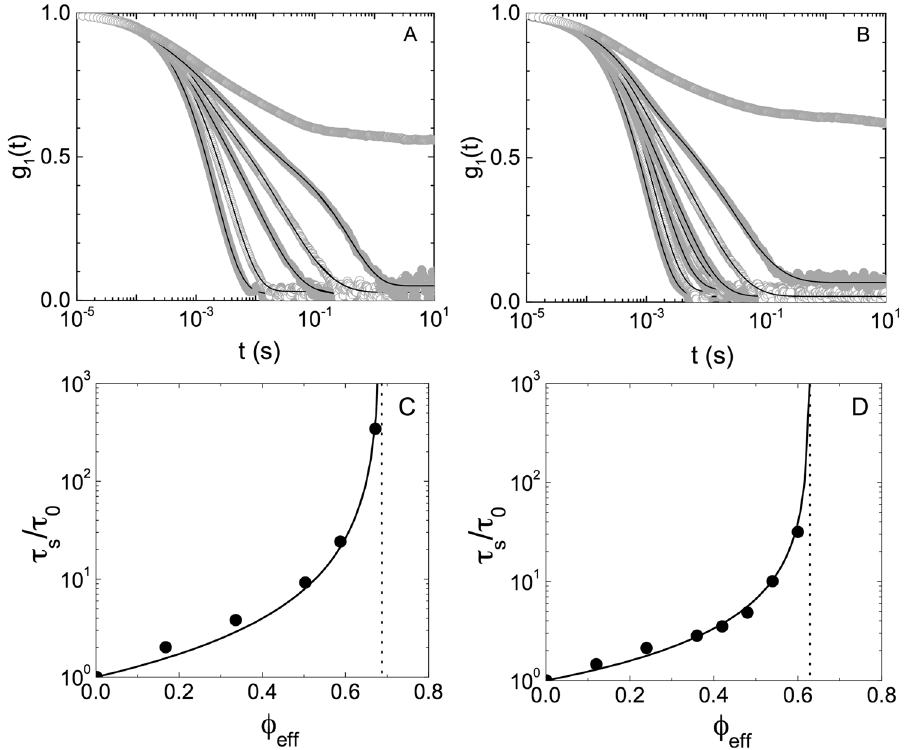
Figure 4. Dynamics of dense suspensions. ( A ) Normalized field autocorrelation functions g 1 ( t ) as a function of delay time t for 50–50 particle mixtures in ZAC solvent at T = 15 °C and effective volume fractions φ eff = 0.17, 0.34, 0.50, 0.59, 0.67, 0.84, from left to right. ( B ) Normalized field autocorrelation functions g 1 ( t ) as a function of delay time t for 50–50 particle mixtures in ZAC solvent at T = 27 °C and effective volume fractions φ eff = 0.12, 0.24, 0.36, 0.42, 0.48, 0.54, 0.6, 0.96, from left to right. ( C ) Normalized slow relaxation time τ s / τ 0 as a function of φ eff at T = 15 °C. ( D ) Normalized slow relaxation time τ s / τ 0 as a function of φ eff at T = 27 °C. Also shown are fitted curves τ s / τ 0 = (1 − φ eff / φ g ) − α as solid lines, where α = 1.6 for T = 15 °C and α = 1.2 for T = 27 °C, and the resulting estimate of the glass transition volume fraction φ g as the dotted